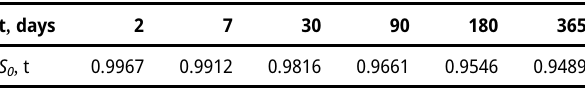
Table  : Underlying survival function of AMPEL MELD.